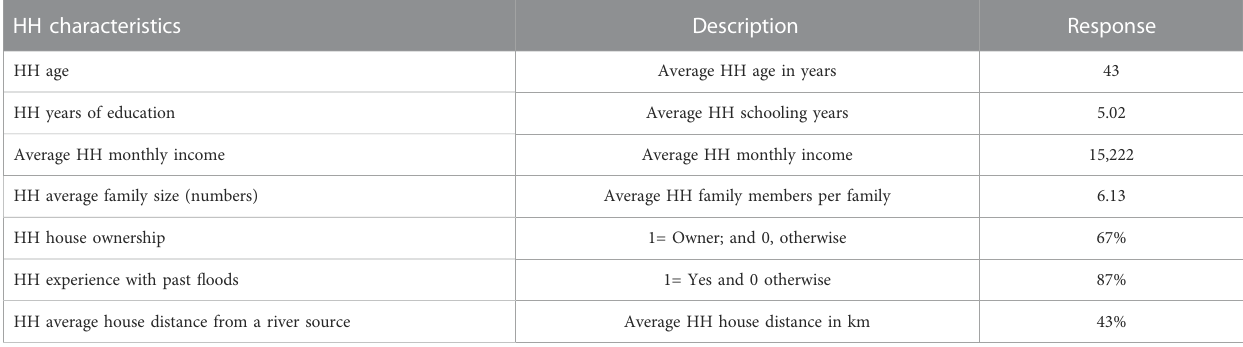
TABLE 1 Respondent ’ s